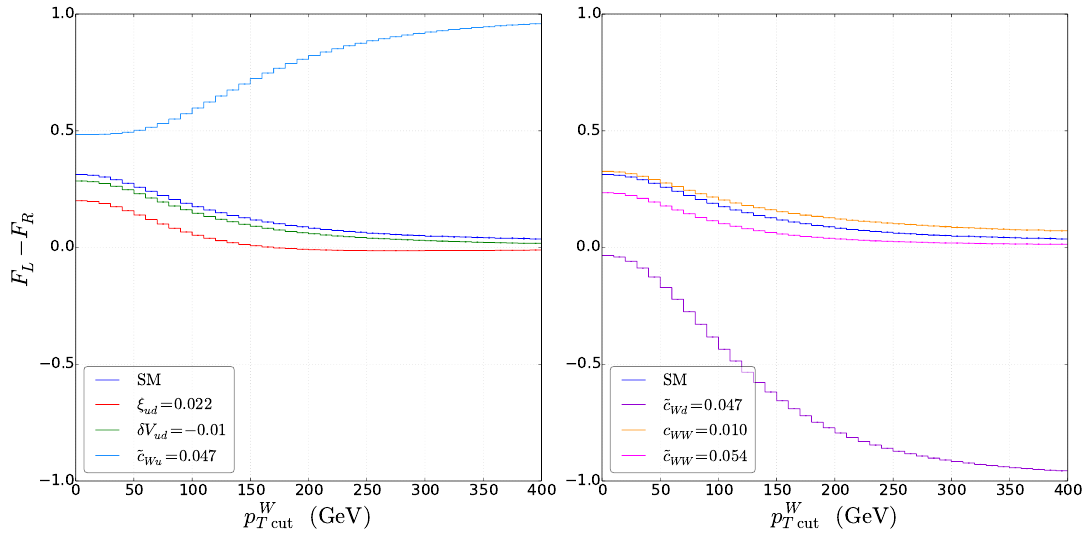
Figure 14 . Longitudinal polarization of the W + boson in W + H production as a function of p W p at S = 14 TeV.